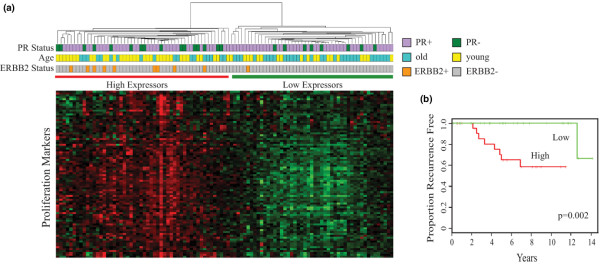
Estrogen receptor-positive breast cancer subsets by gene set enrichment analysis. Assessment of estrogen receptor (ER)-positive breast cancer subsets by gene set enrichment analysis (GSEA) for specific gene signatures. (a) Unsupervised clustering of the 101 primary ER-positive breast cancers shown in Figure 2 based only on expression of the 71-gene proliferation signature shown to be significant by GSEA, revealing two major clusters (high expressors and low expressors of proliferation signature) with significant biases in age and ERBB2 status; horizontal colored bars identify the age cohort, progesterone receptor (PR) status and ERBB2 status of the samples in each column. (b) Kaplan–Meier plots of recurrence events among the 54 ER-positive cases with known clinical follow-up, dichotomized by high (red) or low (green) expression of the 71-gene proliferation signature, with significance determined by log-rank analysis.